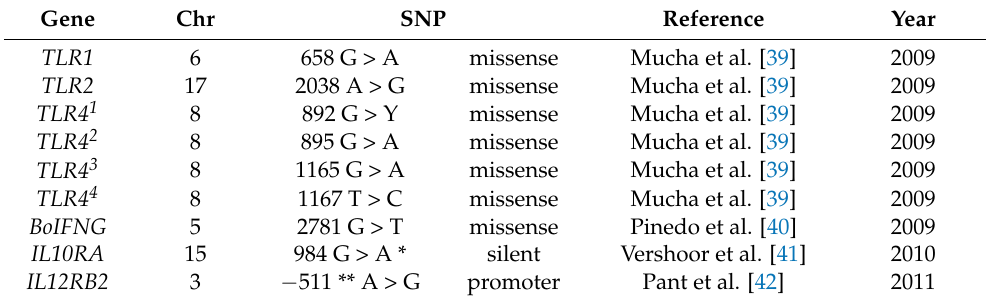
Table 1. Single Nucleotide Polymorphisms (SNPs) of candidate genes selected for this study.